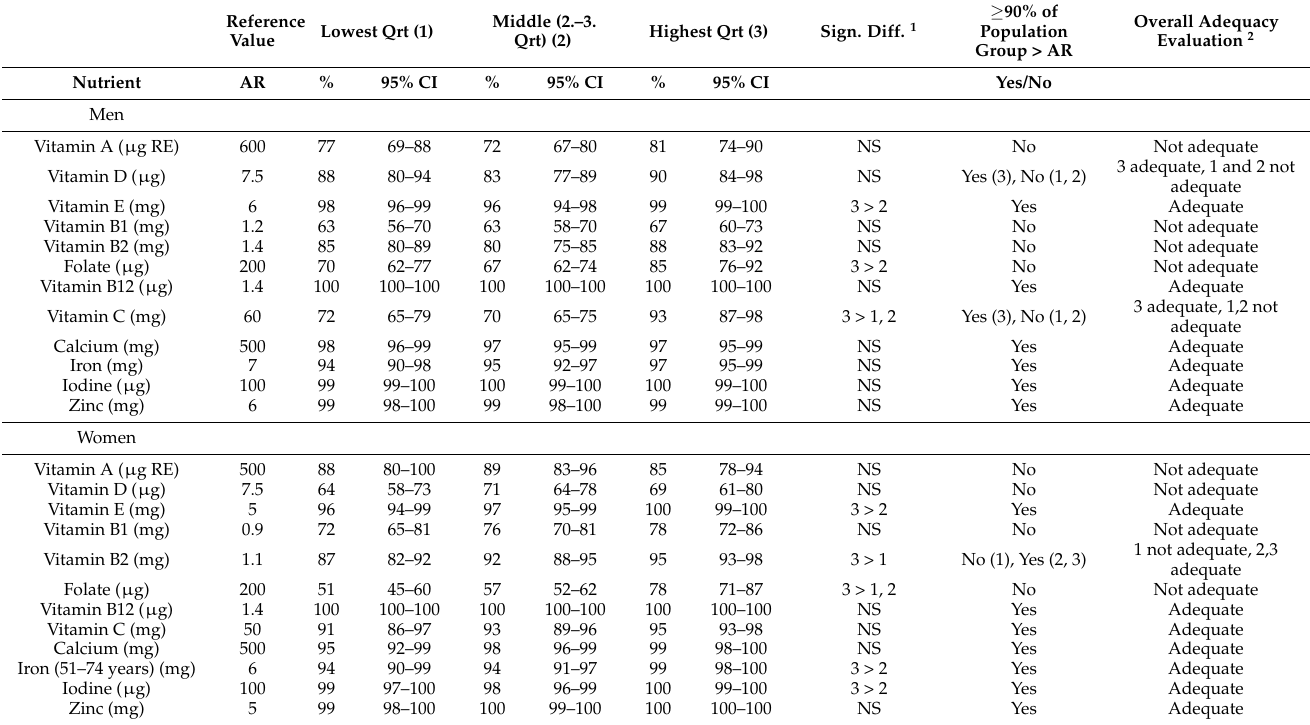
Table 5. Proportion of population groups reaching the average requirement (AR) values, and adequacy evaluation according to usual intake distributions in men and women by income.